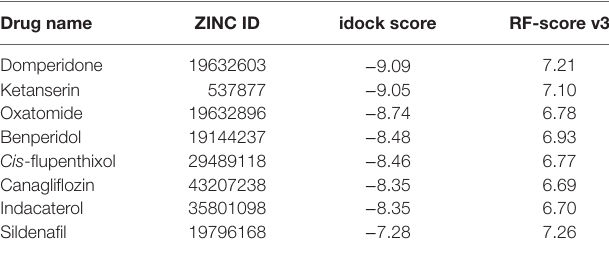
Table 1 | The eight drug candidates shortlisted from in silico screening and later purchased and evaluated in vitro . Drug